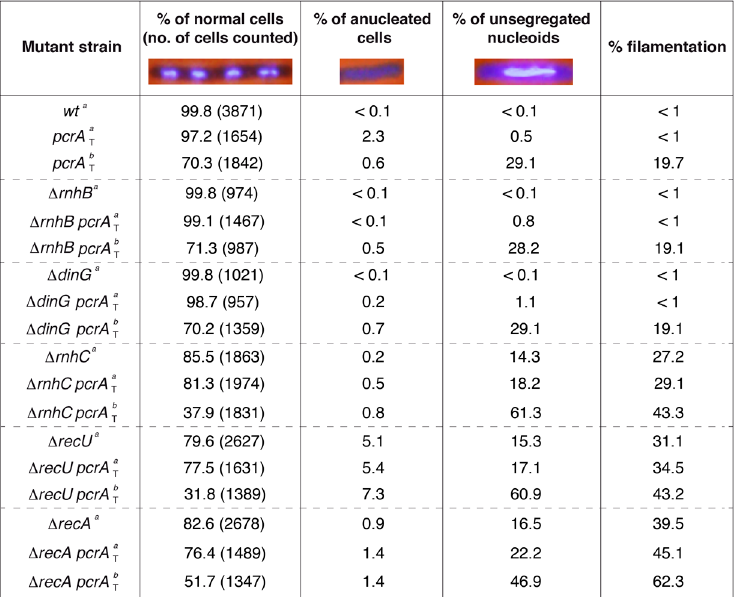
Figure 2. PcrA depletion leads to unsegregated chromosomes in the Δ rnhC and Δ recA context. The indicated strains were grown in LB medium to OD 560 = 0.2 (37 °C), the culture was split and 500 μ M IPTG was added (condition b) or not (condition a). After 60 min, the cultures were harvested, prepared for DAPI DNA-fluorescence microscopy, and the percentage of normal, anucleate, and unsegregated nucleoids determined. The fraction of filamented cells is indicated. Representative fluorescent images of two dividing DAPI-treated cells (DNA stain, light blue) are shown. The pictures are taken at the same amplification. Two not separated cells (four nucleoids) are presented under normal conditions in ~60% of total dividing cells. The mean ± SEM of at least three independent experiments is shown.